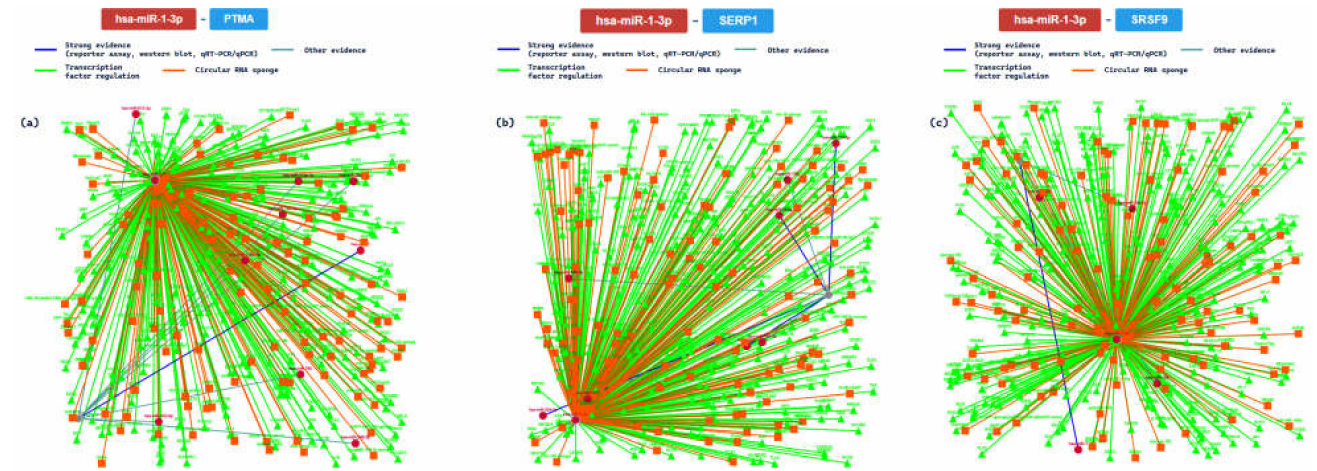
Figure 8. The regulatory network of has-miR-1 and the PTMA gene ( a ); ( b ) shows the regulatory network of the interaction between the tested miRNA and the SERP1 gene; ( c ) shows the network relative to the SRSF9